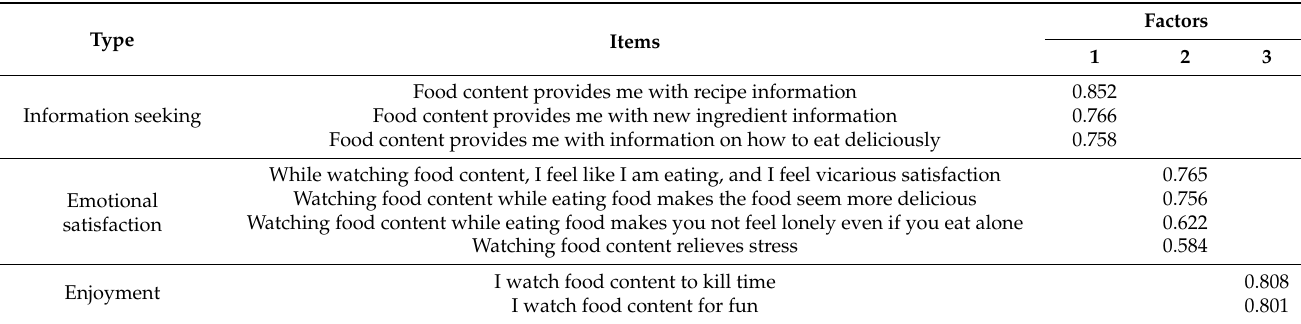
Table 1. Factor and reliability analysis of food-related content watching